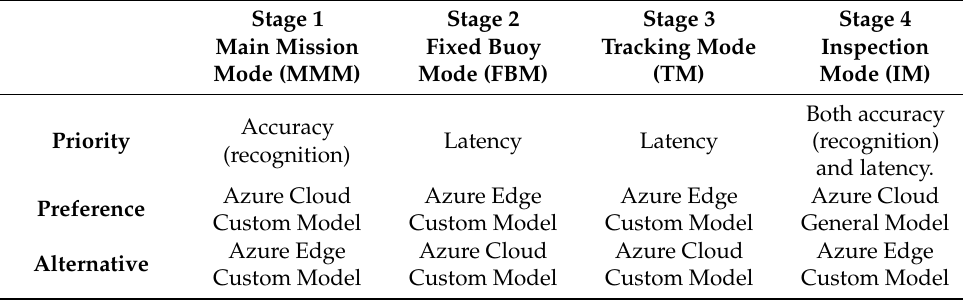
Table 3. AI source preferences according to mission stage.